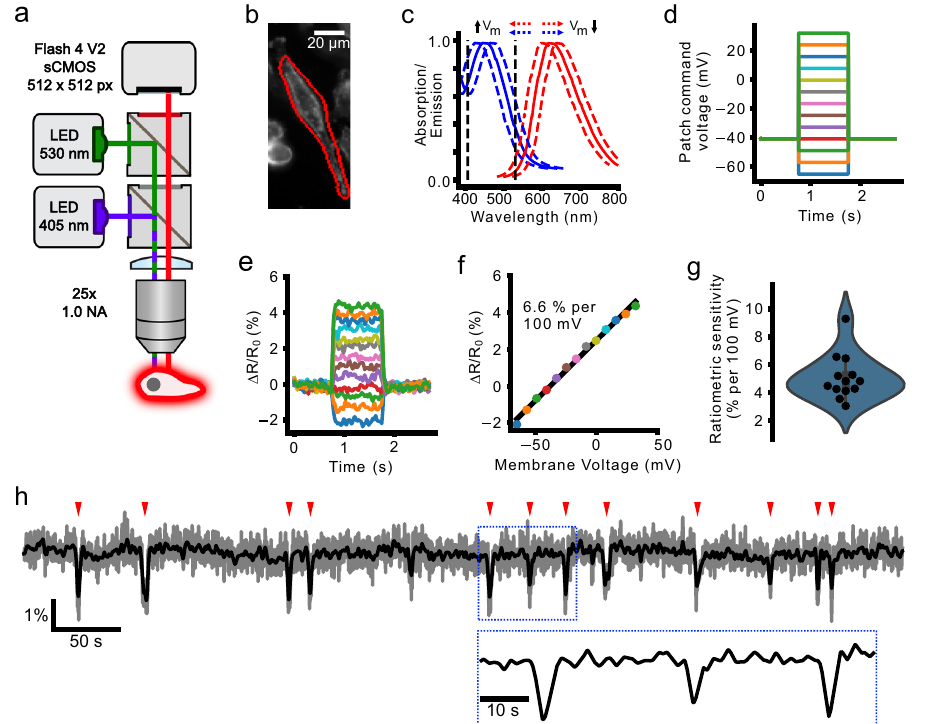
Fig. 1 Electrochromic imaging of MDA-MB-231 cells with voltage dye di-4-AN(F)EP(F)PTEA. a Schematic of the wide fi eld epi fl uorescence imaging system with two-color excitation. b MDA-MB-231 cell stained with di-4-AN(F)EP(F)PTEA with simultaneous voltage clamp c The blue and red lines show di-4-AN(F)EP(F)PTEA ’ s excitation and emission spectra 29 , respectively. Fluorescence is excited by blue and green LEDs on opposite sides of the excitation maximum (black vertical dashed lines). Decreasing or increasing V m causes the excitation spectra to shift right or left, respectively. Decreasing V m , therefore, causes reduced emission in response to blue channel excitation, and increased fl uorescence with green channel excitation and vice versa for increasing V m . d Waveforms commanding the MDA-MB-231 whole-cell voltage clamp for calibration of the ratio of blue- to green-excited fl uorescence with respect to the baseline ( Δ R / R 0 ). e Recorded Δ R / R 0 signal in response to the injected V m waveforms. f Average Δ R / R 0 change with membrane voltage change and a linear fi t to the data indicating the imaging sensitivity (% change in ratio per 100 mV membrane voltage change). g Measured sensitivities for different patched cells with a gaussian kernel estimate (blue envelope). h Example time course of a spontaneously active MDA-MB-231 cell displaying typically observed transient V m hyperpolarisations (indicated by red ticks). Gray, un fi ltered time course, black, gaussian fi ltered time course, sigma = 3 sampling points (0.6